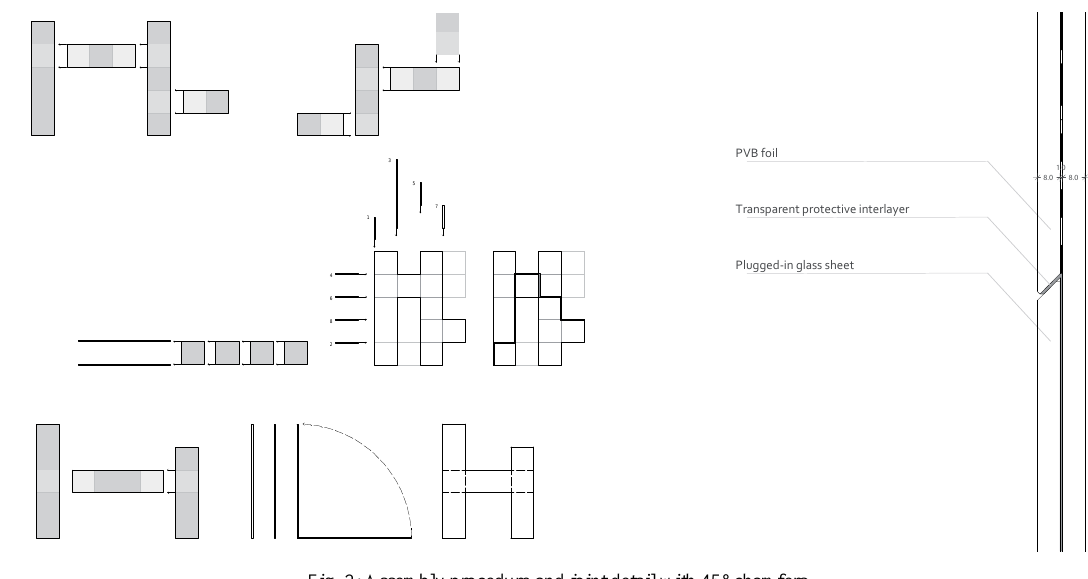
Fig. 2: Assembly procedure and joint detail with 45°